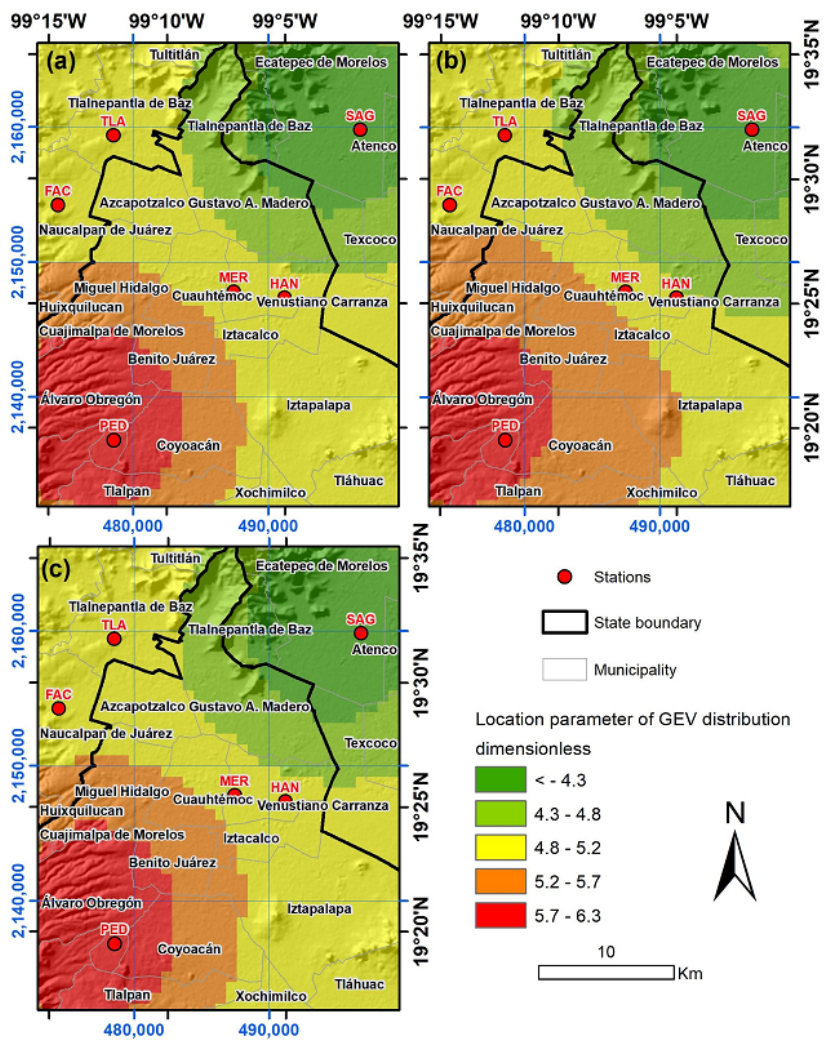
Figure 3. ( a ) Real functions, ( b ) and ( c ) are functions obtained by fitting the parameters of a nonstationary generalized extreme value (GEV) model with P 2 = 10 and P 2 = 80 knots respectively, to simulated data with a sample size of n =